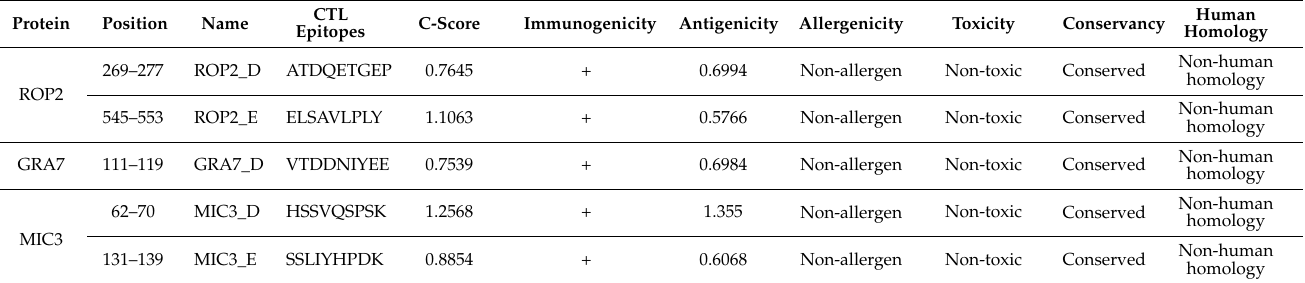
Table 2. The CTL epitopes used in final vaccine construct.